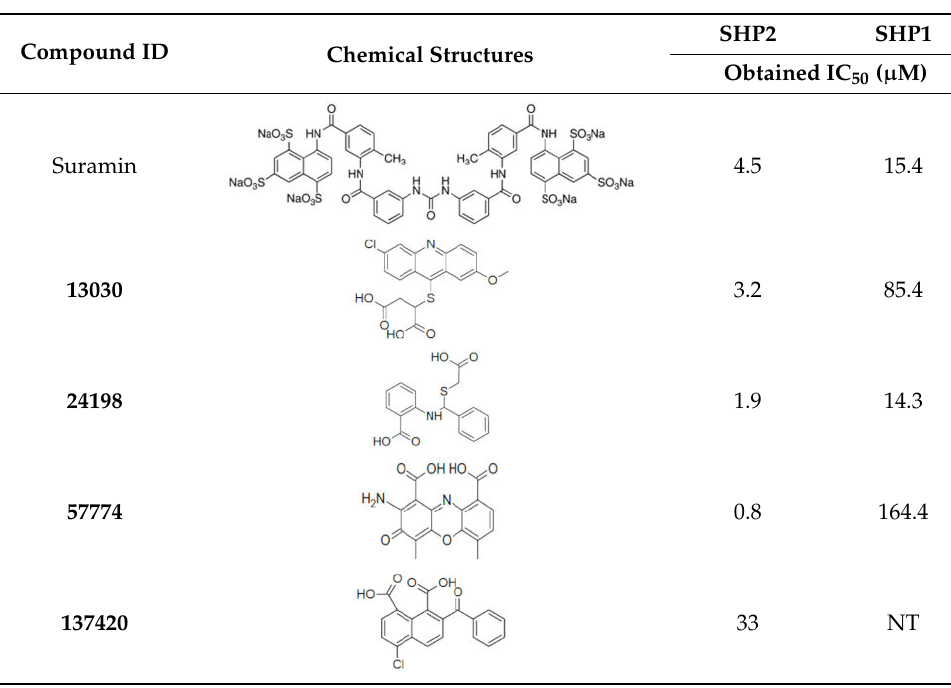
Table 3. IC50 values of compounds NSC 13030 , 24198 , 57774 , 137420 , and the control, suramin, on the activity of SHP2 and SHP1. NT: Not